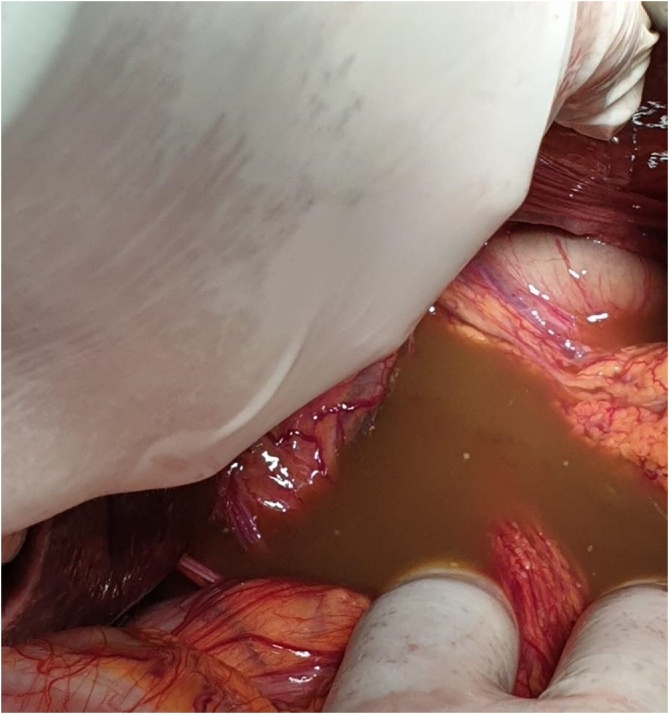
Intraoperative view.